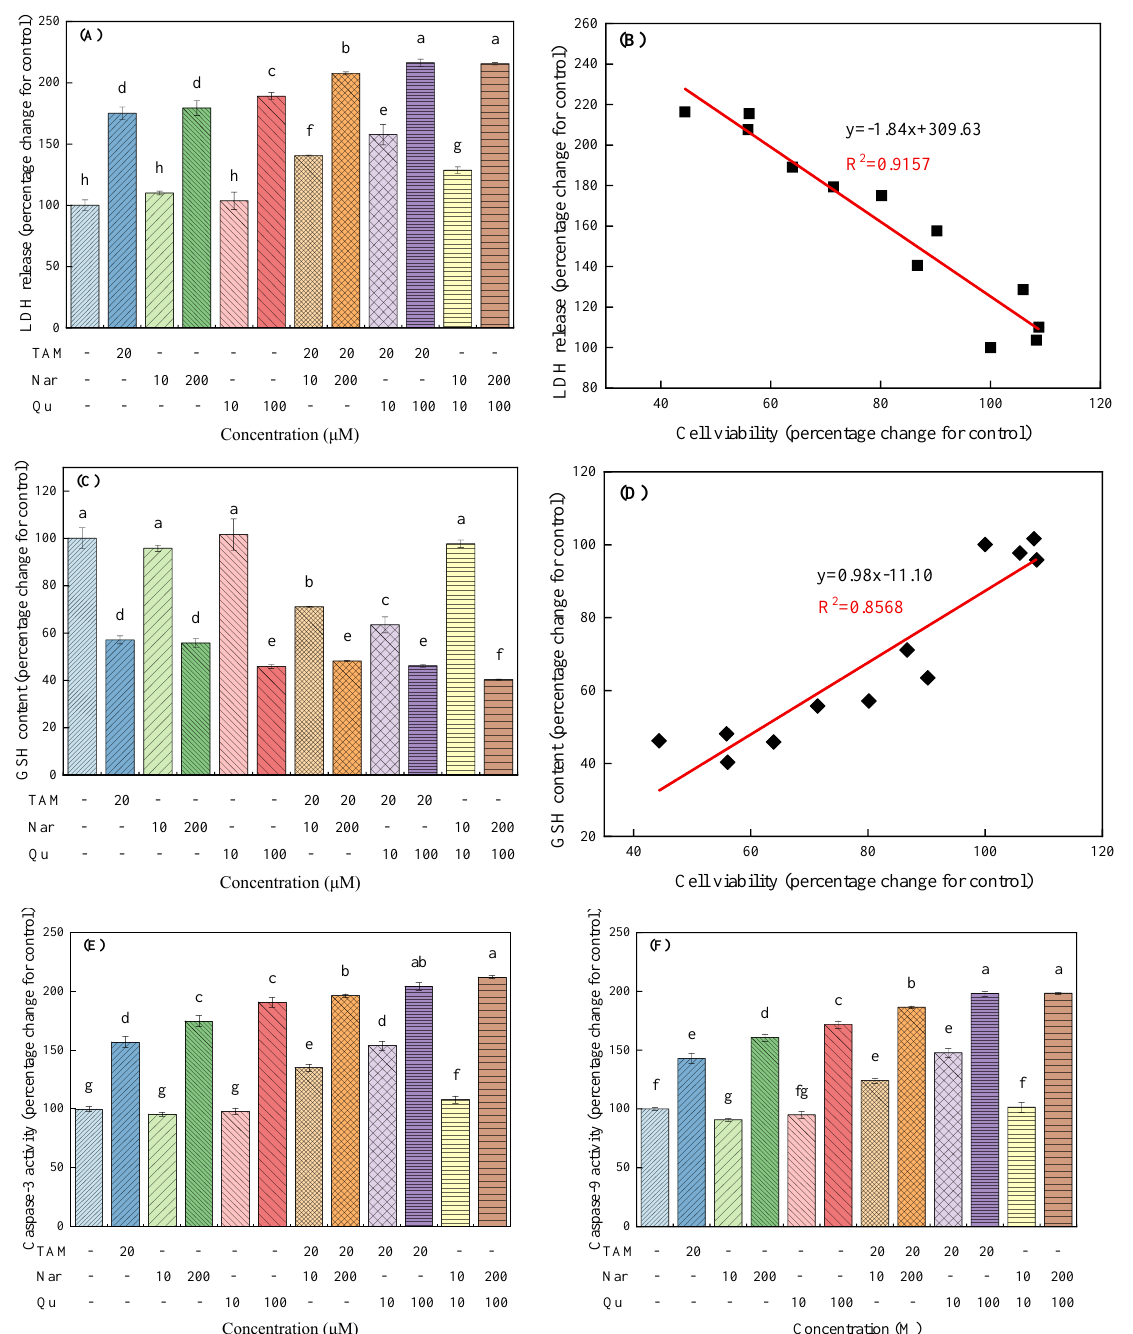
Figure 8. Effects of tamoxifen, naringenin and quercetin on LDH release, GSH content and caspase activity in HepG2 cells. Cells were treated with tamoxifen, naringenin and quercetin alone or in combination for 24 h. LDH release in the culture medium ( A ) and GSH content ( C ) were measured using an LDH cytotoxicity assay and glutathione reductase assay, respectively, according to the manufacturer instructions. The relative correlations between cell viability and LDH release ( B ) or GSH content ( D ) were depicted utilizing the linear fit. ( E , F ) The activities of caspase-3 and caspase-9 were measured using colorimetric assay kits. Results are expressed as mean ± SD of three independent experiments ( n = 6). a–h : Different letters indicate significant differences ( p < 0.05) in LDH release, GSH content and caspase